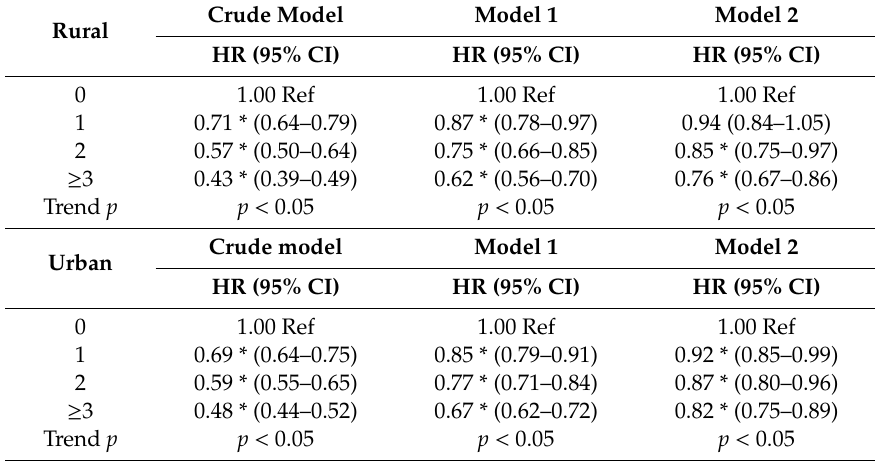
Table 2. HRs for participation in one, two, and three or more di ff erent types of organizations.